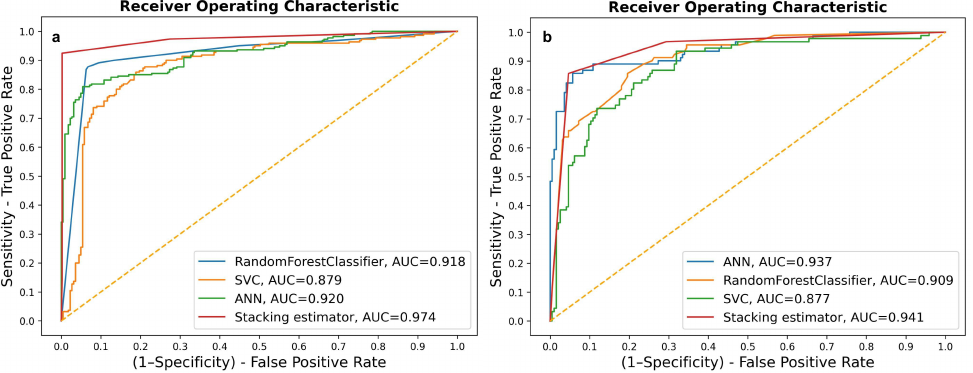
Figure 12. ROC analysis for three models and stacking estimator with AUC values: ( a ) training dataset; ( b ) validation